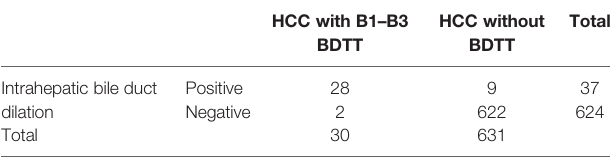
TABLE 3 | Intrahepatic bile duct dilation in HCC patients for BDTT diagnosis.